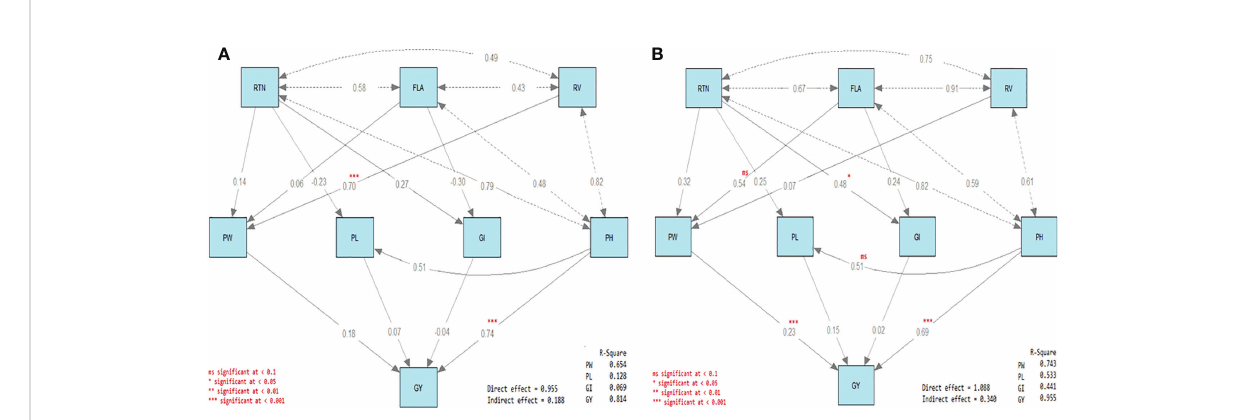
FIGURE 4 Path diagram of the direct and indirect effects of water irrigation regimes on rice traits. Response traits in rice plants under (A) well-watered (control) and (B) drought stress conditions. Each diagram has three types of arrows. The fi rst is the path of a single-headed arrow that is used to de fi ne the causal relationships between two variables, where the variable at the tail of the arrow (independent variable) affects the variable at the head (dependent variable). The second is the covariance, which is a double-headed arrow connecting two variables and de fi ning the covariance between them. The third is the variance, which is a double-headed arrow pointed at the same variable and de fi ning the variance of that